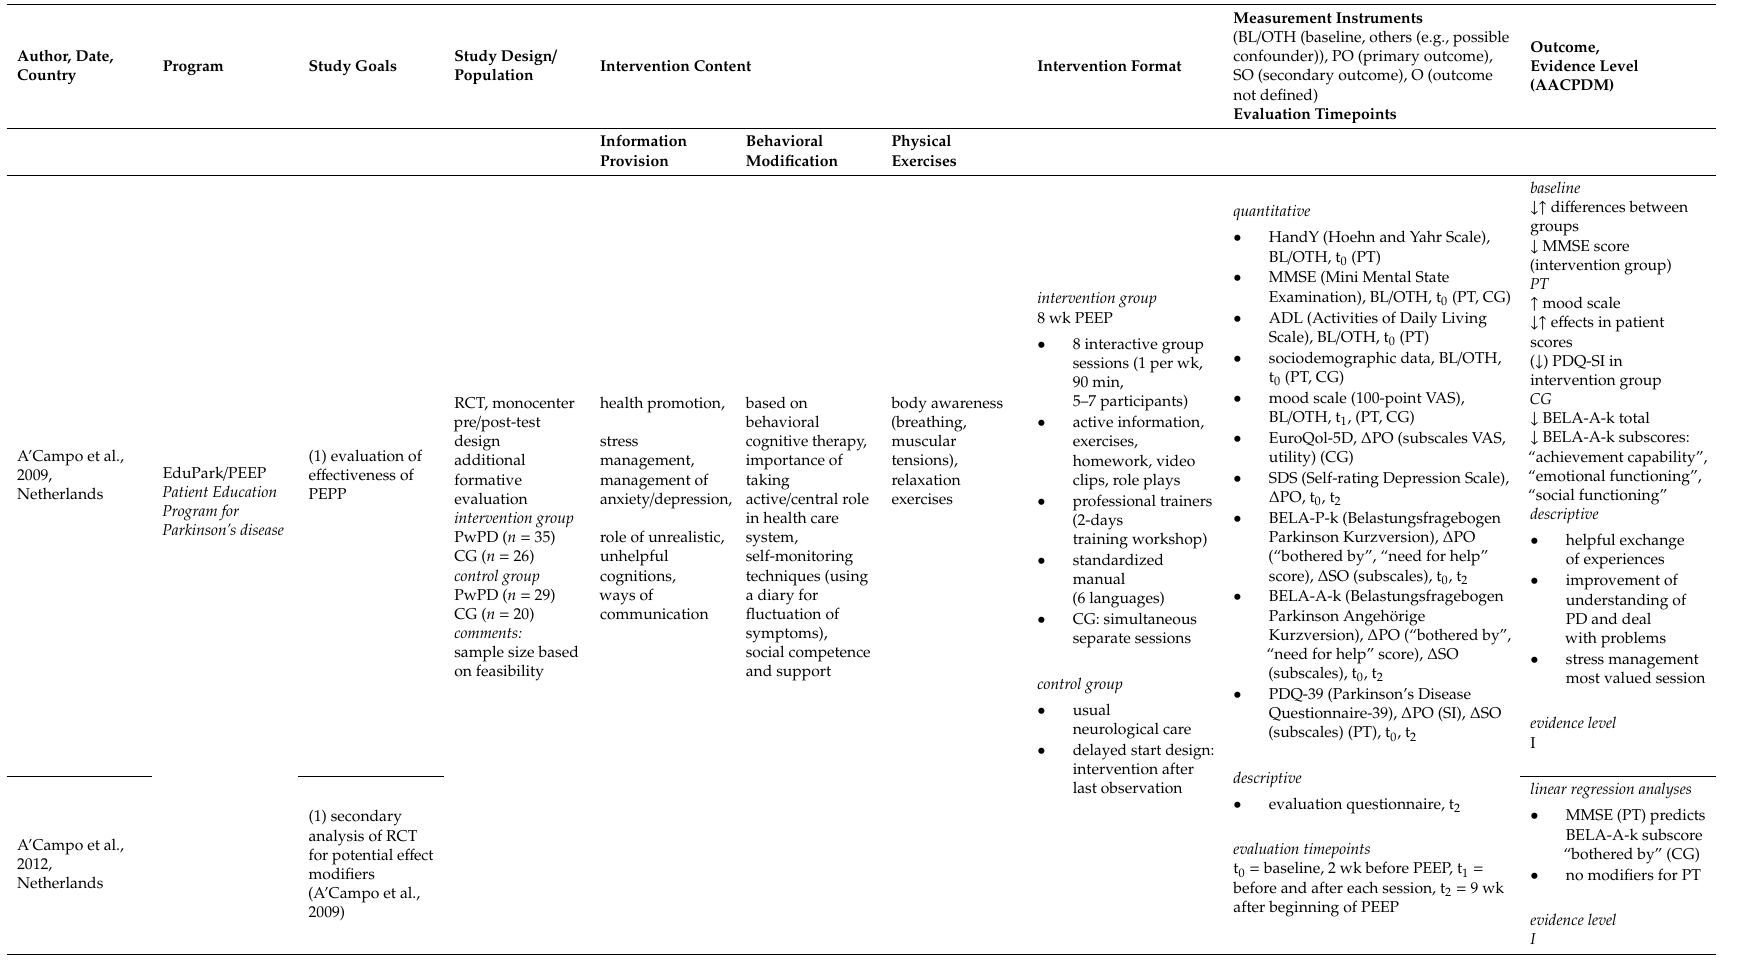
Table 1. Quantitative evaluation